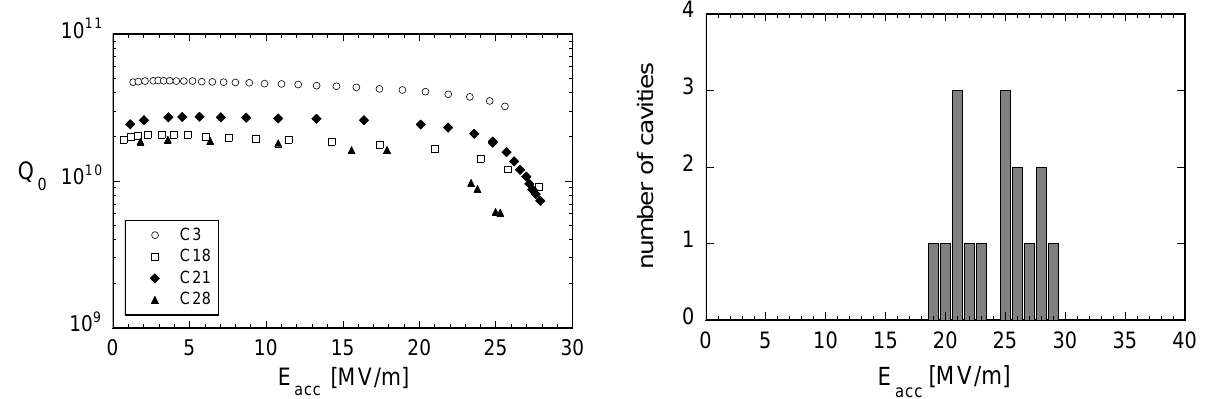
FIG. 14. (a) Excitation curves of the best 9-cell resonator of each of the four manufacturers. (b) Distribution of maximum gradients for the resonators of class 1, requiring a quality factor Q 0 $ 5 3 10 9